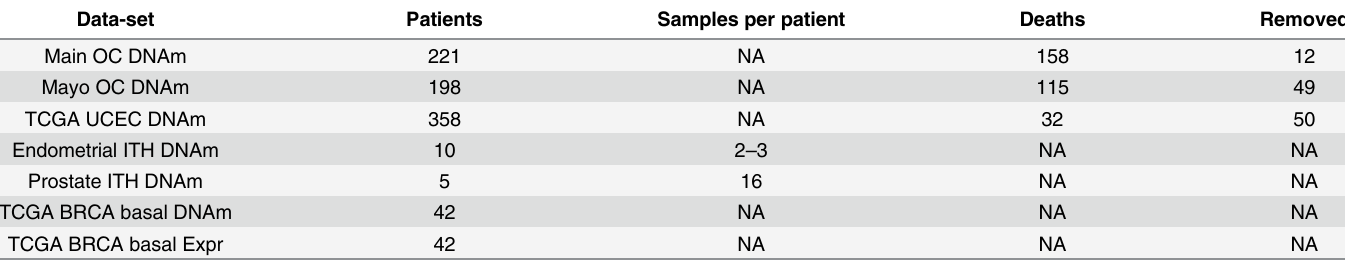
Abbreviations: ITH, intra-tumour heterogeneity; DNAm, DNA methylation; OC, ovarian cancer; UCEC, uterine corpus endometrial carcinoma; BRCA, breast cancer invasive